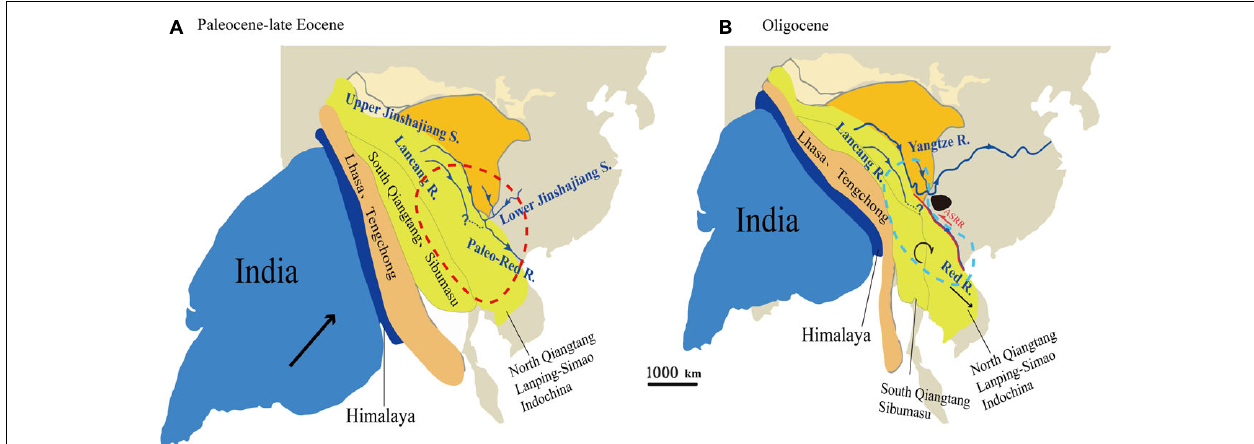
FIGURE 7 | Schematic geodynamic evolutionary model of the paleo-drainage evolution of East Asia and schematic diagram of the ancestral distribution of the Quercus franchetii complex from the Eocene to Oligocene (based on Replumaz and Tapponnier, 2003; Royden et al., 2008; Yan and Chen, 2018). (A) Paleocene to Late Eocene. The red dotted area indicates the possible ancestral distribution area of the Q. franchetii complex in the Paleogene; (B) the Oligocene. The black area indicates the area where the early evolution of the ancient Red River was captured (Nanpan River area). The blue dotted area shows the ancient Red River area in the Oligocene